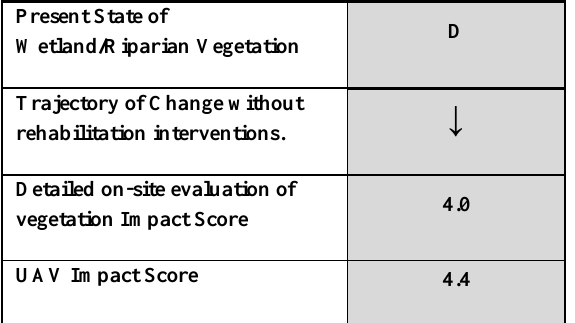
Table 3. Vegetative Health of the system and trajectory of